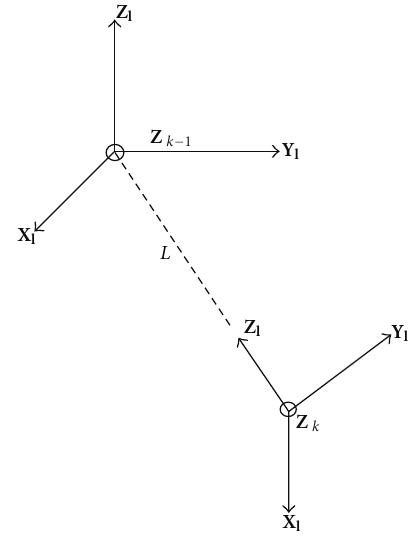
Figure 10: Position external measurements Z k − 1 and Z k and the corresponding local reference frames ( X l , Y l , Z l ). L is the scalar displacement between the two